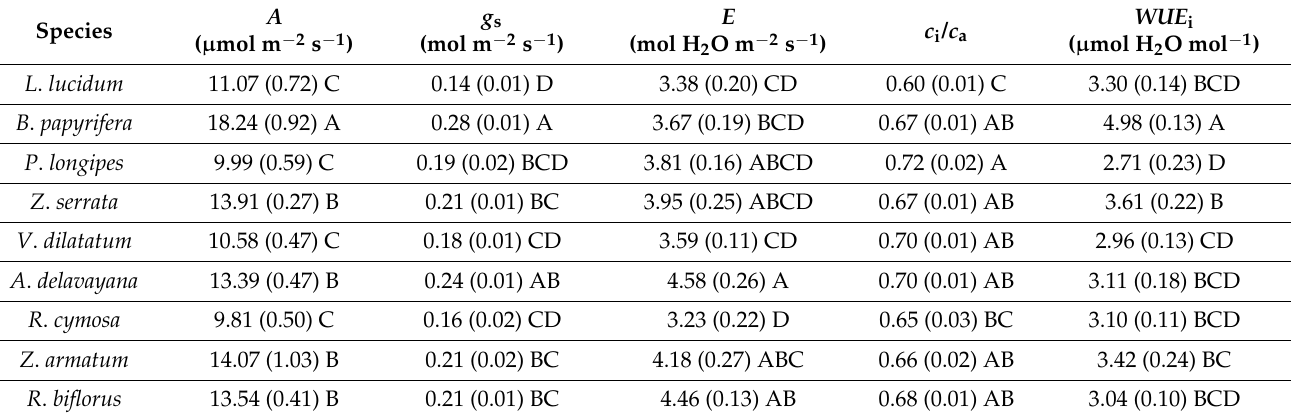
Table 2. Leaf gas exchange of nine species across six plots. A , net photosynthetic rate; g s , stomatal conductance; E , transpiration rate; c i /c a , ratio of intercellular to ambient partial pressure of CO 2 ; WUE i , instantaneous water use efficiency. Values represent mean ± SE. N = 4 for each species in the specific plot. Capital letters indicate significant differences ( p < 0.05) among